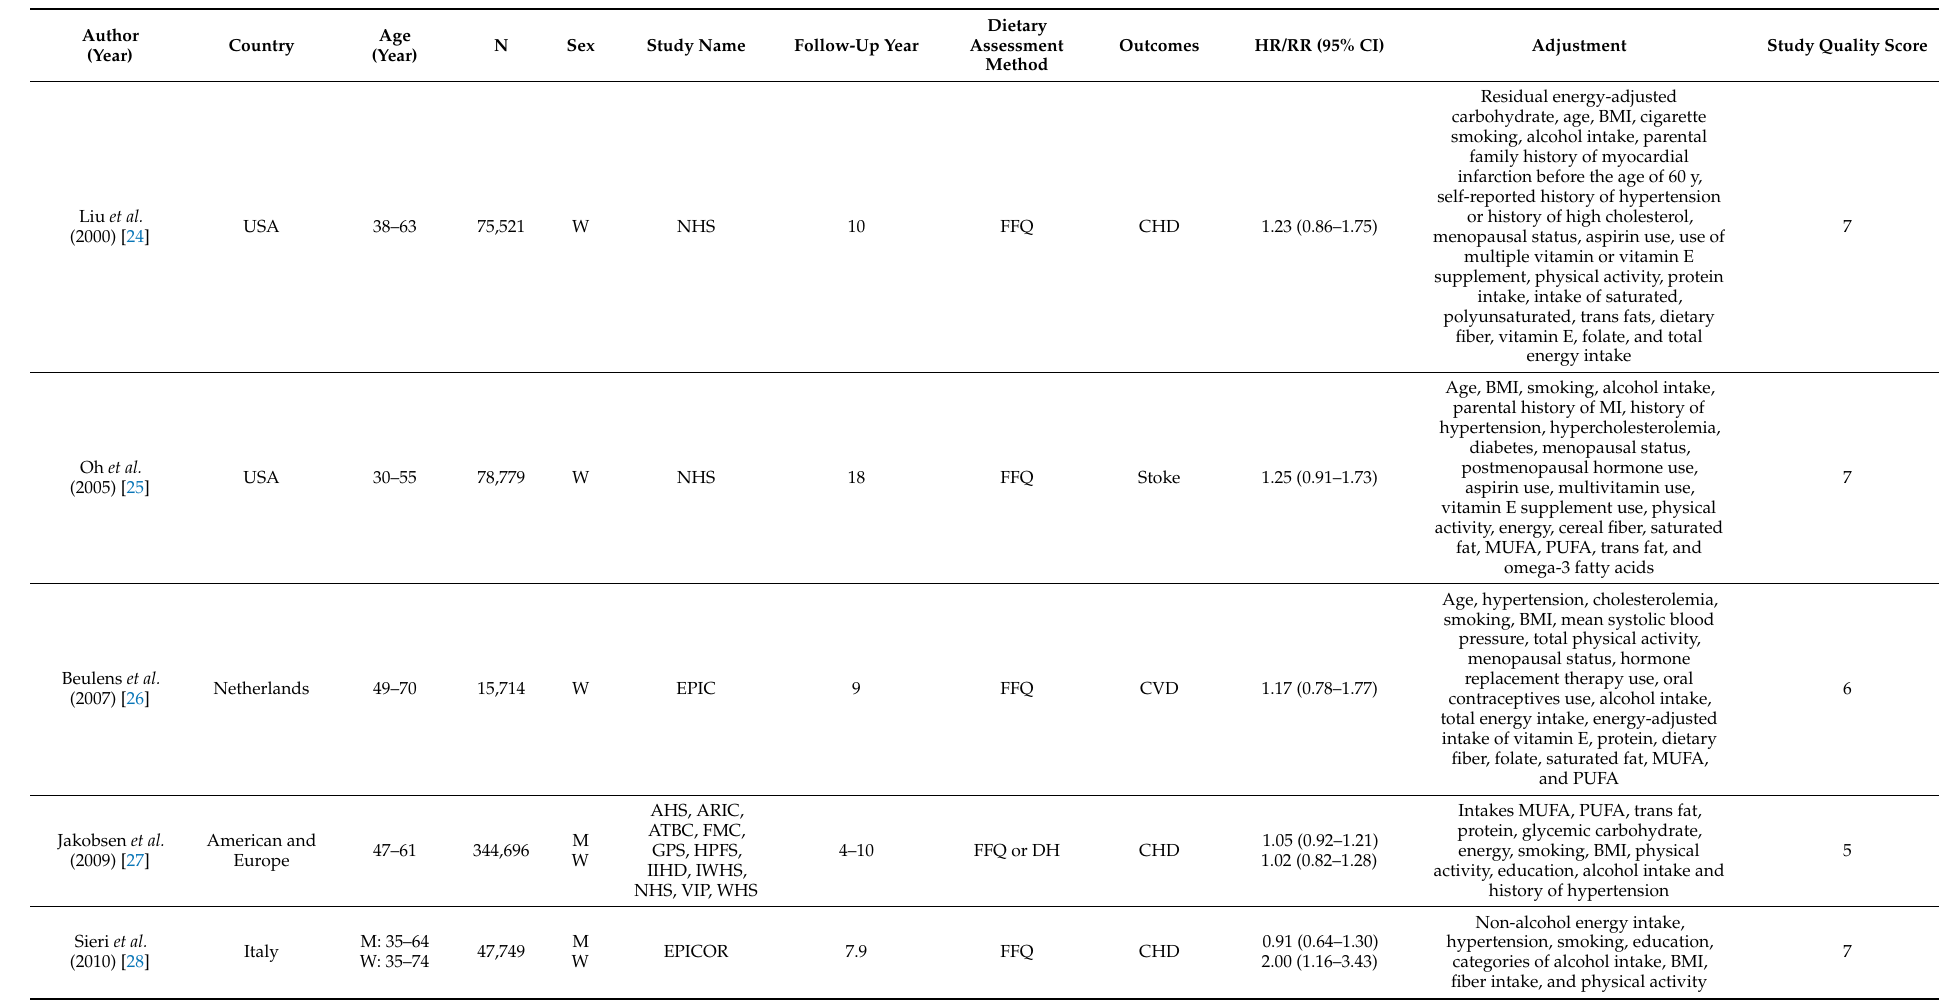
Table 2. Characteristics of studies included in the